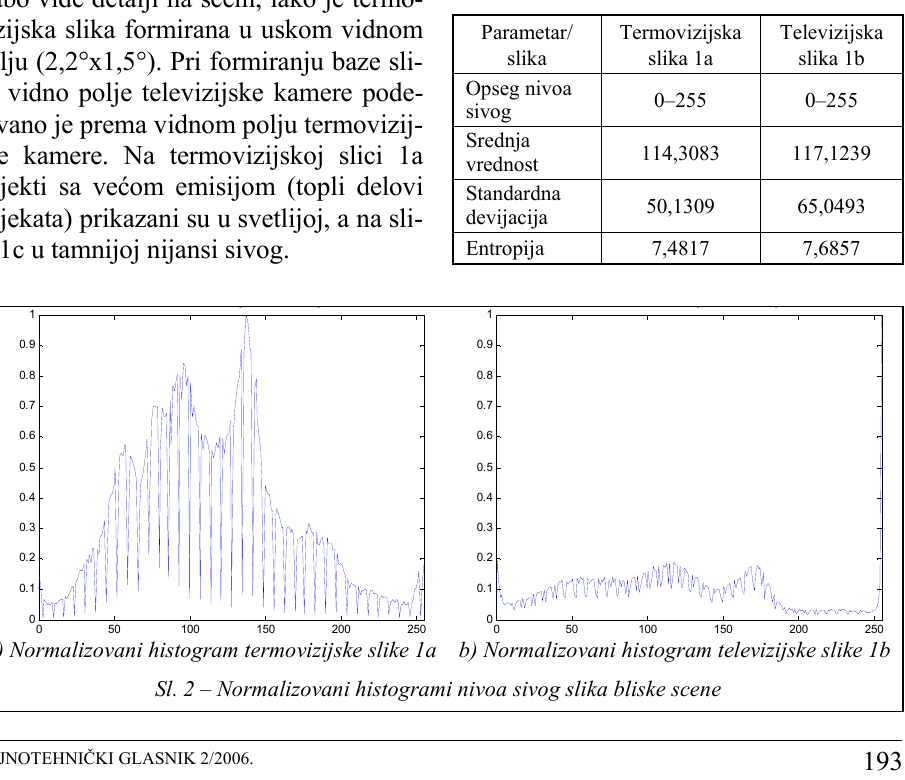
U tabeli 1 dati su: opseg nivoa sivog, srednja vrednost, standardna 1a i 1b